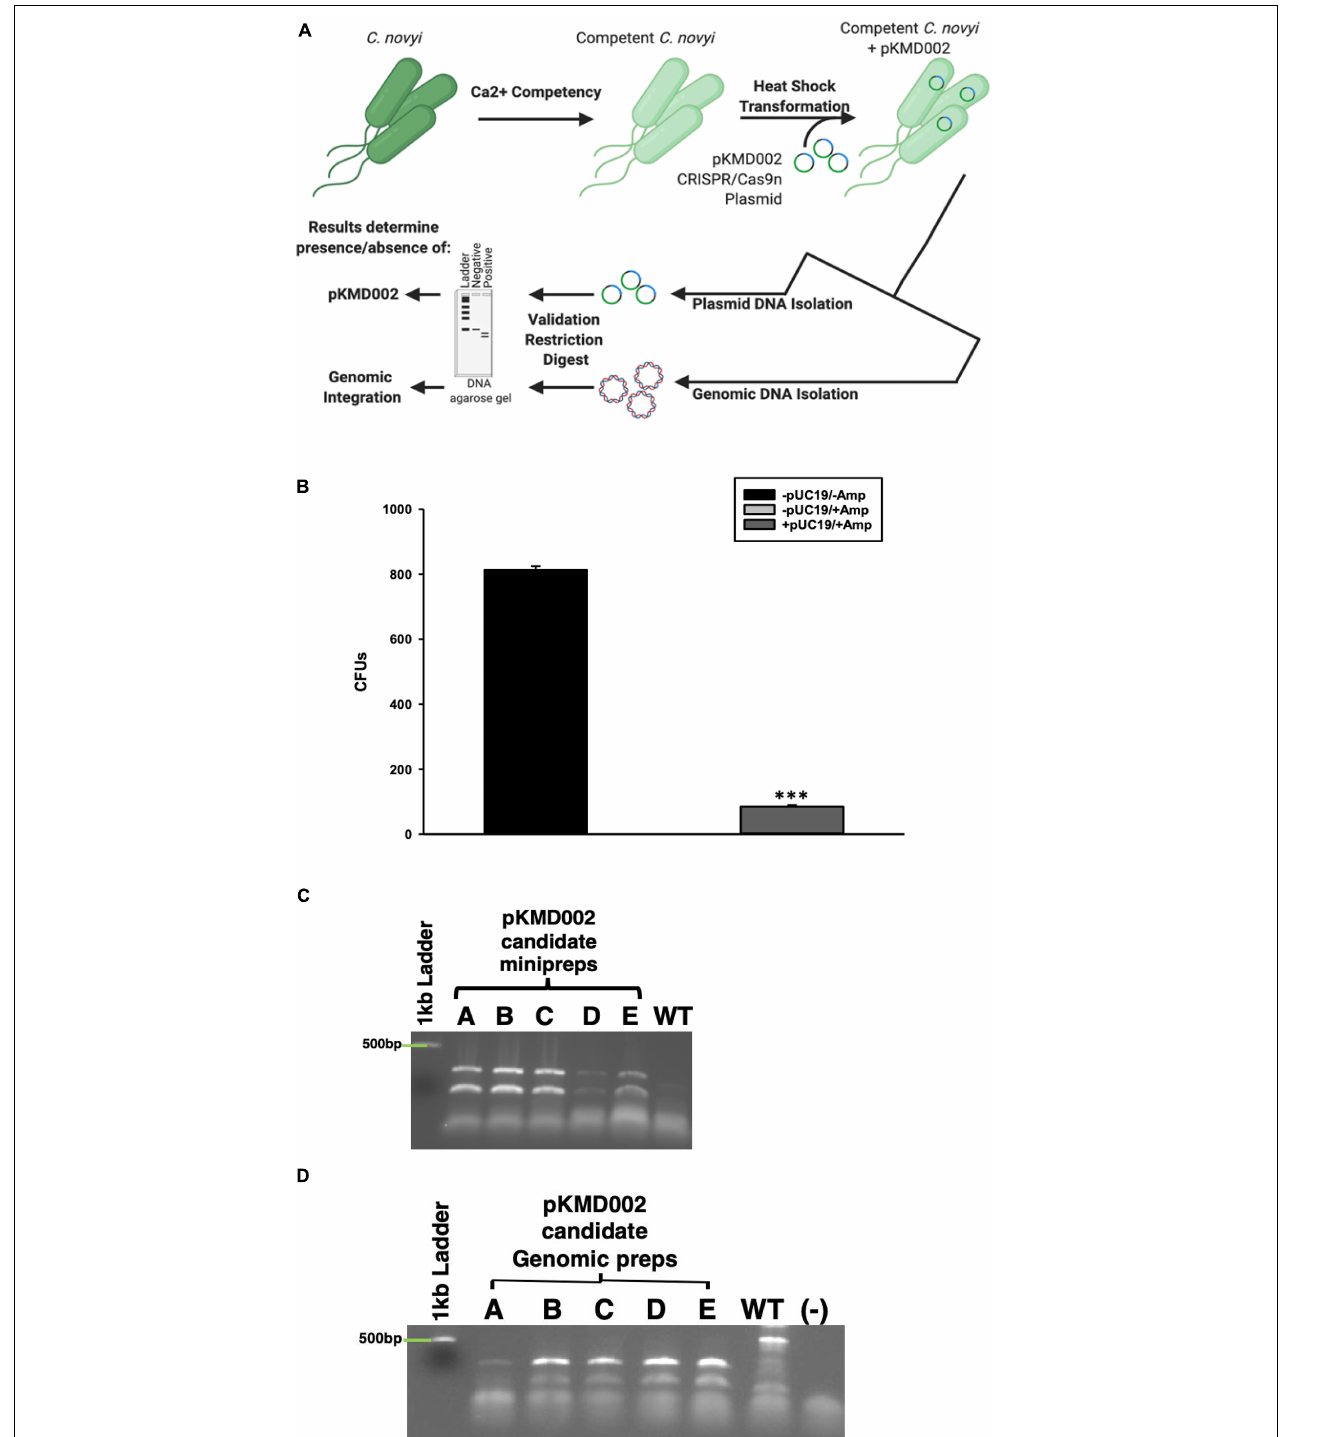
FIGURE 5 | Calcium Competent C. novyi Transformations. (A) Schematic representation of experimental flow. (B) Resulting colony forming units after Clostridium novyi cells underwent calcium competent transformation with the E. coli plasmid pUC19, which contains a gene encoding ampicillin resistance. Statistical significance was determined to be p < 0.001 through the application of the Holms-Sidak test ( n = 3 experiments). (C) After calcium competent C. novyi were transformed with pKMD002, five candidates (A–E) underwent plasmid minipreperation, and subsequent restriction digest to confirm plasmid present in cultures. Singlet is negative for presence, doublet is positive due to the presence of a EcoR V site designed in the insert. (D) After calcium competent C. novyi were transformed with pKMD002, five candidates (A–E) underwent genomic DNA isolation, and subsequent restriction digestion to confirm plasmid present in cultures. Singlet is negative for genomic insertion, doublet is positive due to the presence of a EcoR V site designed within the insert. ∗∗∗ indicates a statistical significance of p < 0.001. Frontiers in Microbiology |